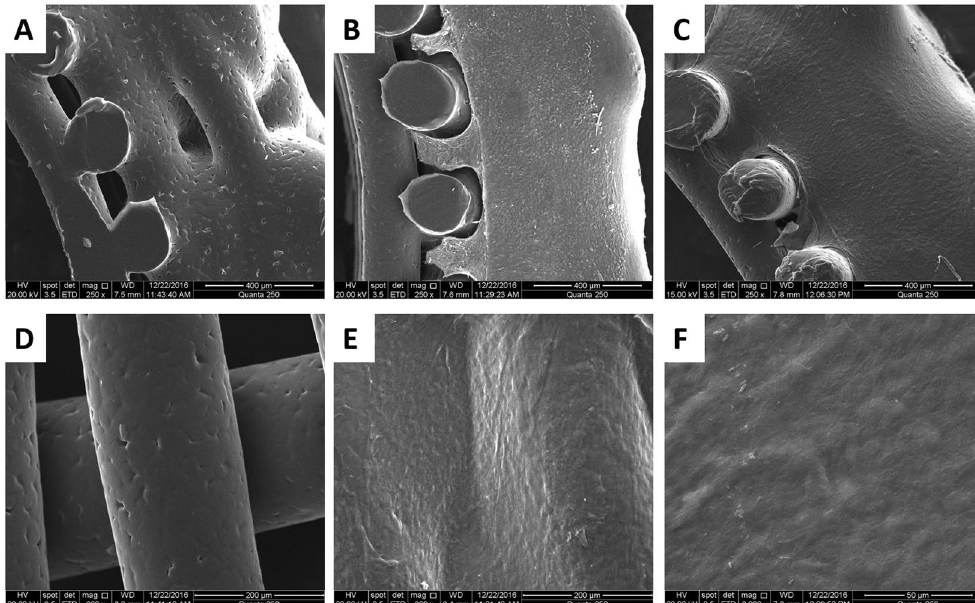
Figure 3. Observation of TET by SEM. Transverse sections of the convolutions of ( A ) Blank scaffold, ( B ) 2-weeks cultured TET, ( C ) 4-weeks cultured TET. ( D ) Surface of bare-PCL bars. ( E ) Surface of 4-weeks TET, note PCL bars presented with an ECM-like appearance covering the surface. ( F ) Enlarged image of the surface of the ECM-like tissue on the TET. Scale bars: ( A – C ) 400 μ m, ( D and E ) 200 μ m, ( F ) 50 μ